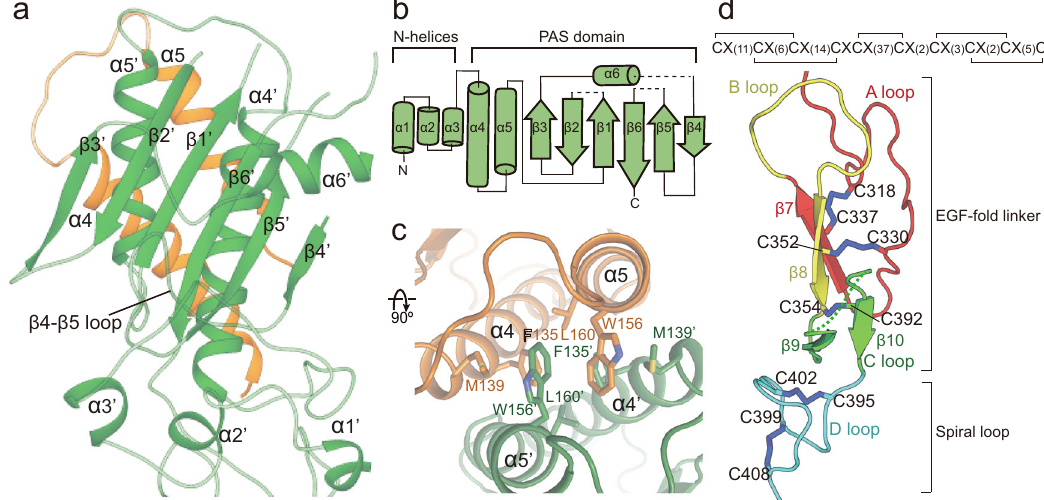
Fig. 2 Structure of the extracellular domain of GPR158. a Structure of the N-terminal helices (bottom) and the PAS domain (top) of GPR158 in the view shown in Fig. 1b. b Topology diagram of the N-terminal helices and the PAS core of GPR158. Dotted lines indicate disordered loops. c Close-up view of the dimeric interface between the GPR158 PAS domains in a top view from a . d The CR domain stabilized by disul fi de bonds shown in black lines (top) and blue sticks (bottom).